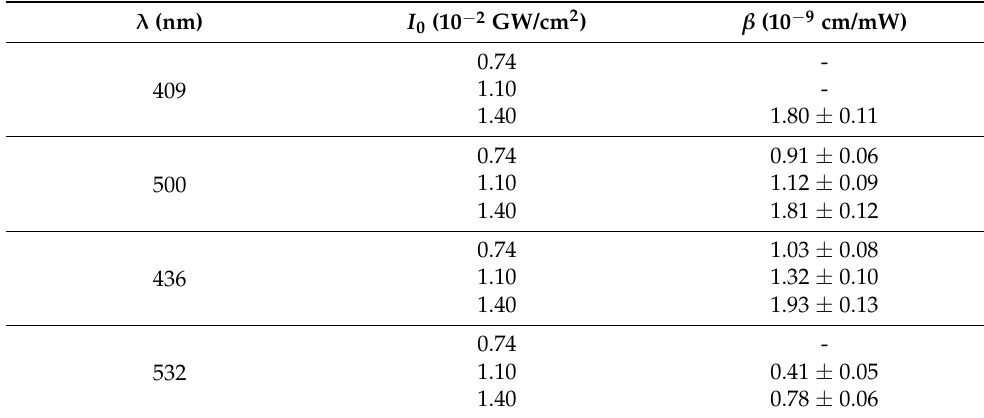
Table 1. Nonlinear optical parameters of the Ti 3 C 2